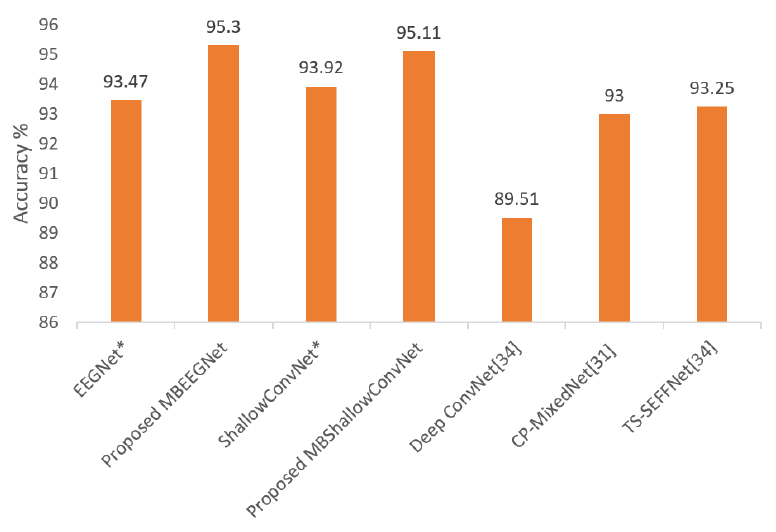
Figure 10. Average classification accuracy on the HGD; * means